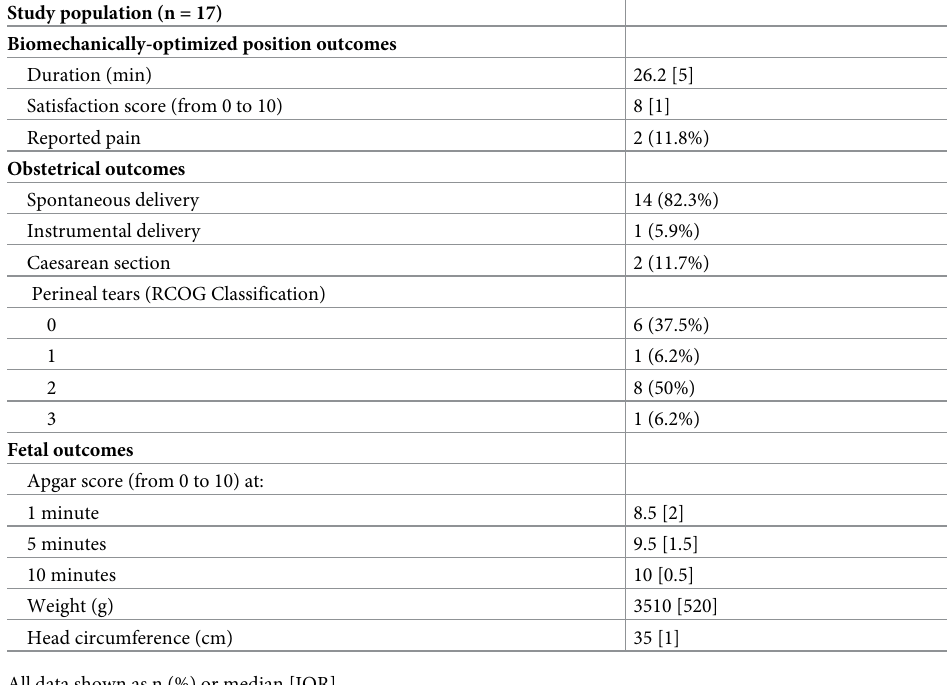
Table 2. Outcomes for the 17 women who maintained the optimized position for at least 20 minutes.